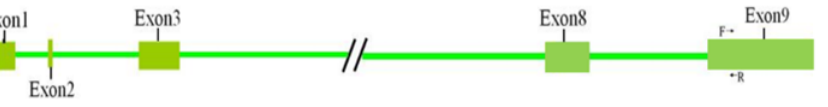
Figure 1. LRRC8B gene structure. Note: the green boxes in the figure indicate exons, and “F” and “R” refer to the upstream and downstream primers, respectively.